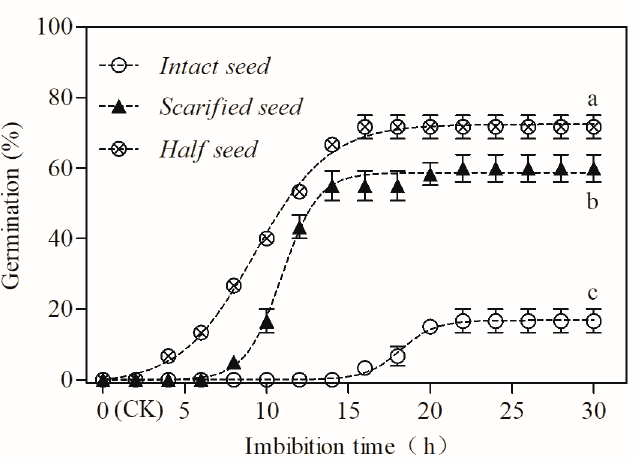
Figure 2. Germination of the isolated embryos at constant and alternating temperatures. Germination was performed at constant temperatures (5, 10, 15, 20, 25, and 30 ◦ C) or alternating temperatures (12/22, 22/31, 14/22, and 5/10 ◦ C) with a 12 h light/12 h dark cycle and PPDF = 121 µ mol · m − 1 · s − 1 . Each treatment had four replicates and 30 seeds were used for each replicate. There are no significant differences between the data labeled with the same lower case letters ( p = 0.05).